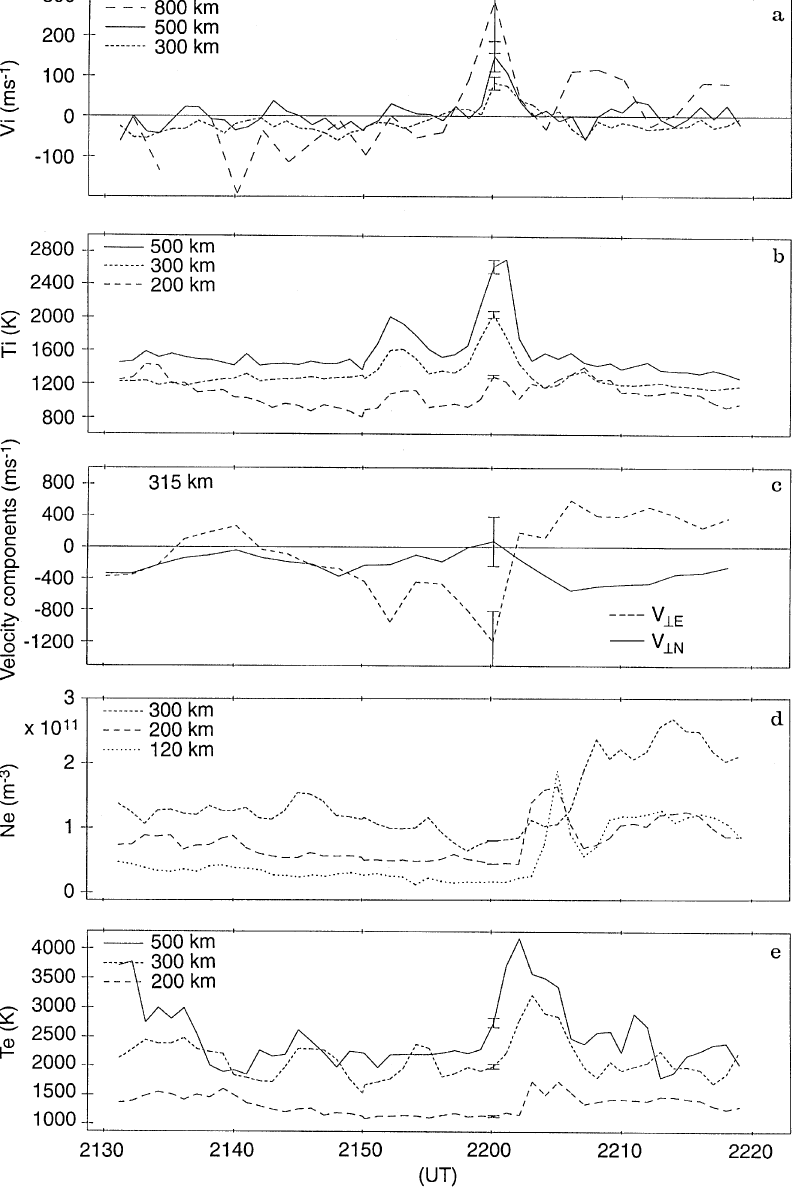
Fig. 2. a EISCAT SP-UK-UFIS UHF (300 and 500 km) and VHF (800 km) measurements of the vertical ion velocity on 17 January 1990. Positive values indicate upward ion flow. b UHF measurements of the vertical ion temperature at 200, 300 and 500 km. c Zonal and meridional components of ion velocity, calculated from UHF tristatic observations at 315-km altitude. d UHF long-pulse (200 and 300 km) and power-profile (120 km) measure- ments of electron density. e UHF observations of electron temperature at 200, 300 and 500